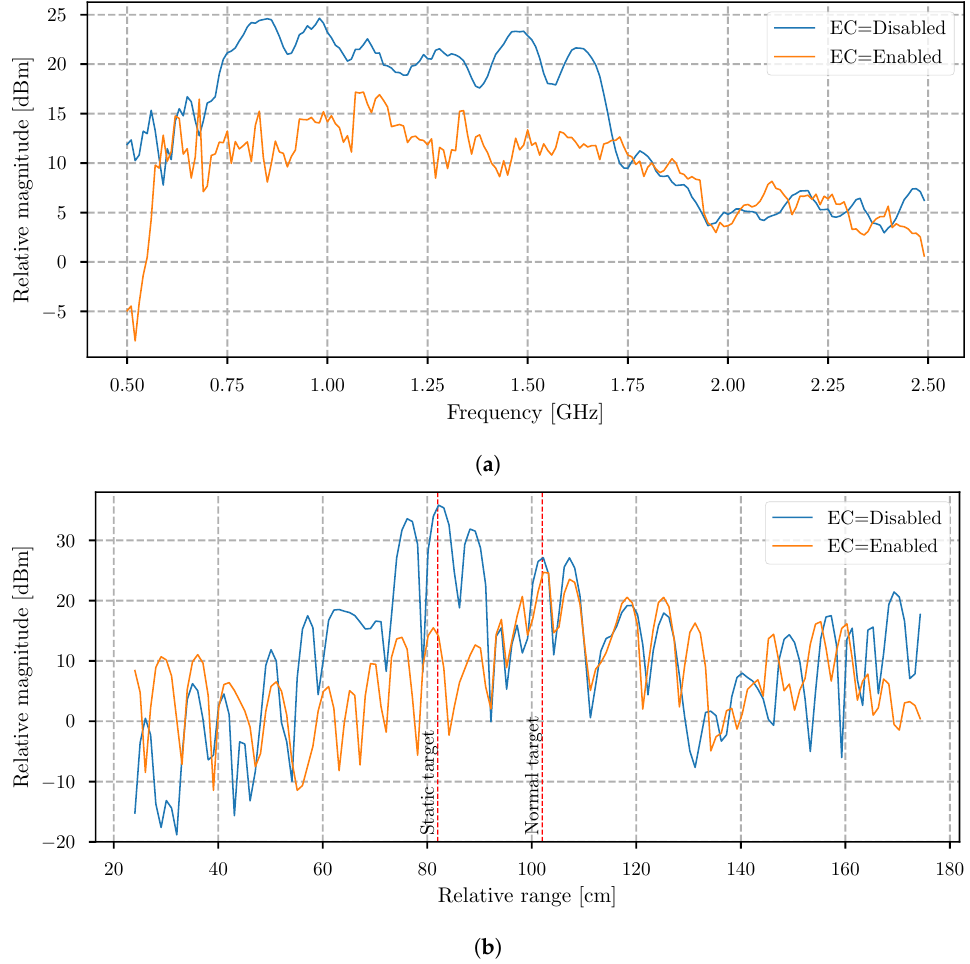
Figure 9. ( a ) Average magnitude of the data in the frequency domain to the cross-range 55 cm, when EC is disabled and enabled. ( b ) Average magnitude of the data in the time domain to the cross-range 55 cm, when EC is disabled and